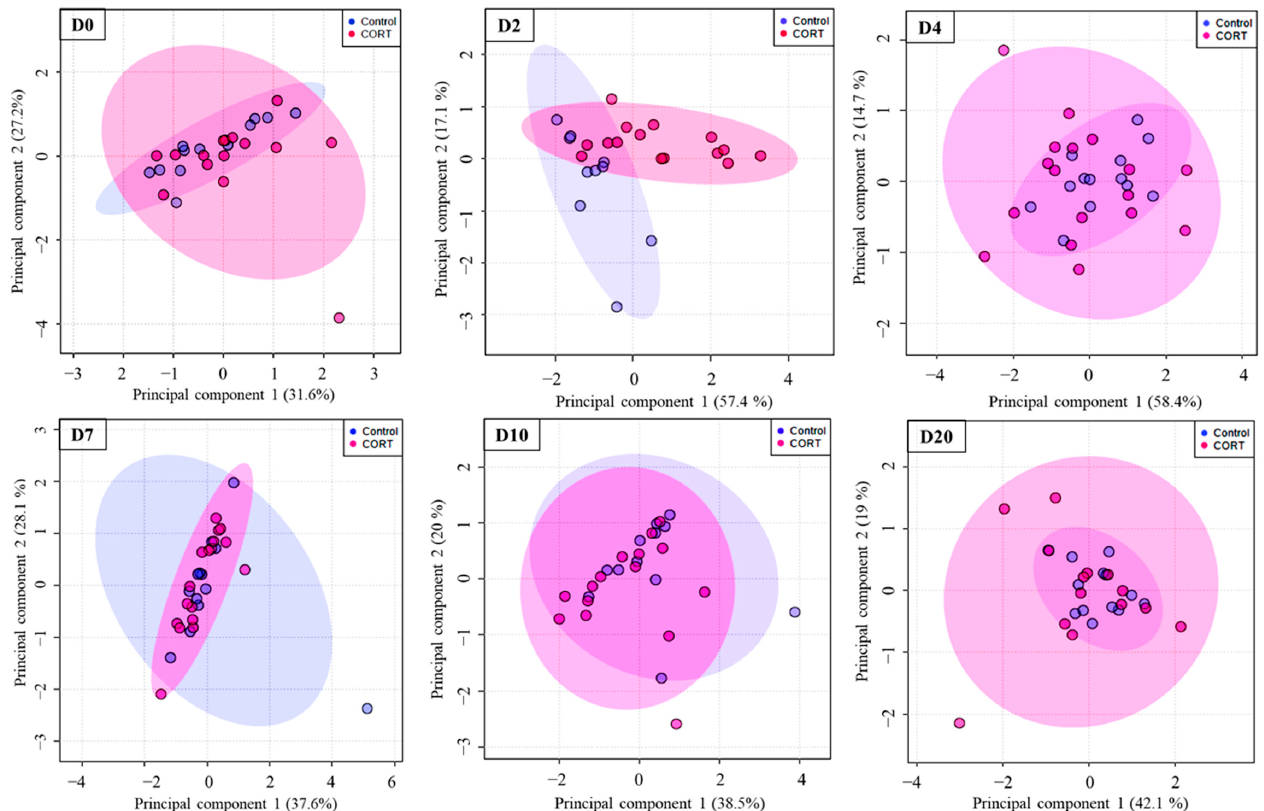
Figure 2. Principal component analysis (PCA) score plots of serum metabolites of lesser scaup ( Aythya affinis ) using data from before (D0), during (D2, D4), and after (D7, D10, D20) the active period of the implant. Pink and blue ellipses represent the 95% confidence region for CORT (treatment) and control, respectively. Overlapping 95% confidence regions indicate similarity between metabolite profiles in the two groups The separation of 95% confidence regions into clusters indicates a notable difference between metabolite profiles (D2). The percentage of variability explained under each principal component is shown within parenthesis on the x- and y-axes. Sample sizes on D0, D2, D4, D7, D10, and D20 were 28, 26, 31, 31, 28, and 28, respectively. The partial least squares discriminant analysis (PLS-DA) model on metabolite data on D2 showed statistical significance with a 10-fold cross-validation (CV) value of 0.88 (accuracy), 0.67 (R2), and 0.52 (Q2), which validated the clustering seen on PCA (Figure 3a). This model also showed acceptable prediction accuracy using permutation tests ( p = 0.01), indicating a significant difference between the metabolite profiles between CORT and con- trol ducks on D2. The Variable Importance in Projection (VIP) metabolites that contributed ethanolamine, 3-hydroxybutyrate, glutamine, indole-3-acetate, and threonine (Figure 3b, Table 2). Glycerol and alanine had VIP scores <1, indicating that these two metabolites did